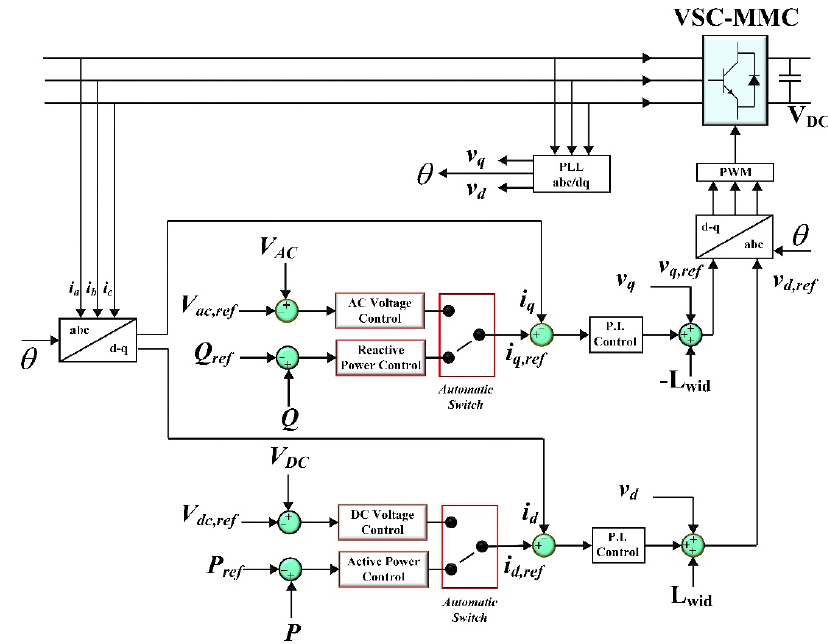
Figure 6. The control structure of the VSC-based MTDC system .